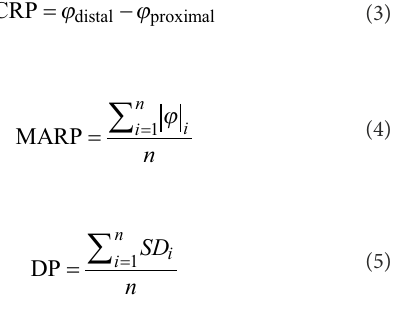
calculated using formula (2) and standardized according to the phase diagram of the four quadrants (Figure 4). CRP values range from − 180 ° to 180 ° , where a CRP close to 0 ° indicates that the two joints move “in-phase,” whereas a CRP close to 180 ° or − 180 ° represents an “anti-phase” motion of the two joints (Sheikhi et al., 2021). CRP values were calculated based on the difference between the distal joint and the proximal joint using formula (3) presented below. A positive value of CRP indicated that the proximal joint dominated the distal joint, whereas a negative value of CRP indicated that the distal joint dominated the proximal joint. MARP represents the mean value of each joint’s phase angles on the curve and is calculated using formula (4), and DP indicates the standard deviation of each point on the overall curve and is calculated using formula (5).